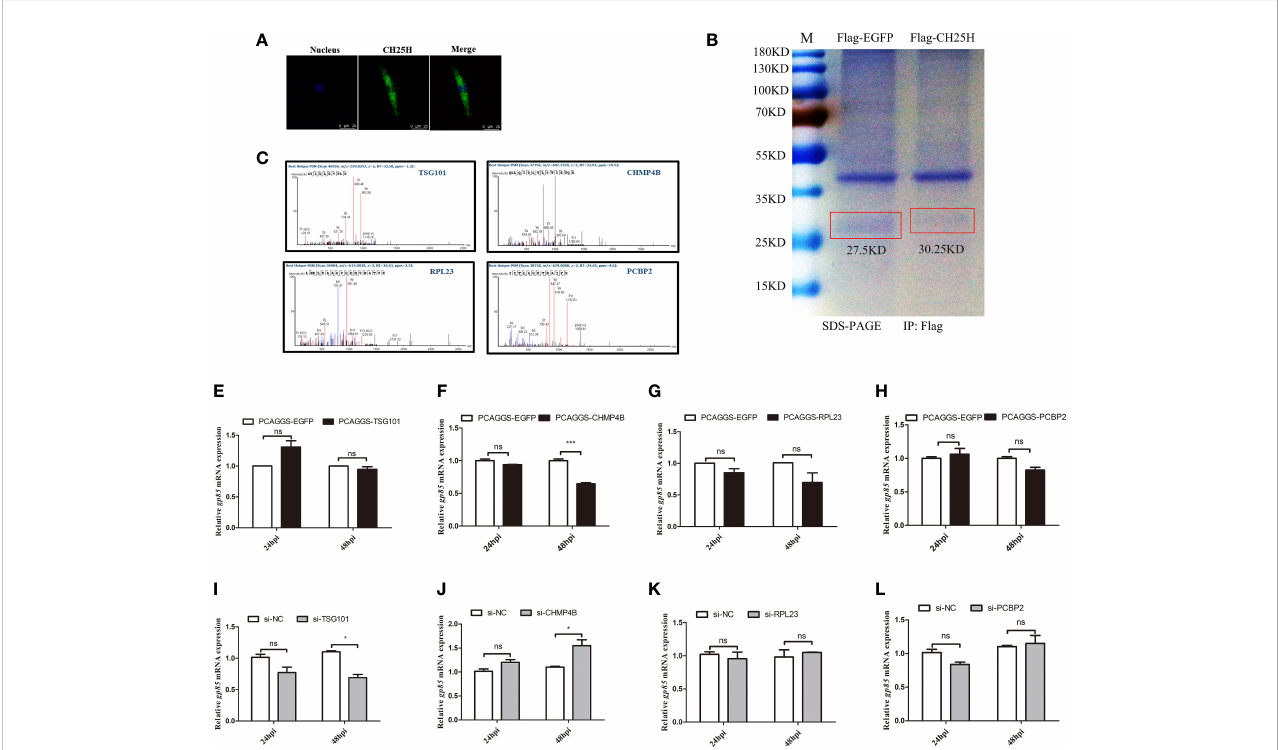
FIGURE 5 The identi fi cation of candidate CH25H-interacting proteins. (A) fl ag-tagged CH25H was expressed in DF-1 cells for 24 h and subsequently infected with ALV-J (10 5 TCID 50 /0.1mL) for 48 h. CH25H localization was analysed by immuno fl uorescence with anti-FLAG antibody (green). Nuclei were visualized with DAPI (blue). Scale bar, 75 m m. (B) The Coomassie brilliant blue staining of CH25H detected with an anti-FLAG antibody. (C) Mass spectrogram of candidate CH25H-interacting proteins, including TSG101, CHMP4B, RPL23, and PCBP2. (D-G) TSG101 (D) , CHMP4B (E) , RPL23 (F) , and PCBP2 (G) were overexpressed in DF-1cells for 24 h and subsequently infected with ALV-J (10 5 TCID 50 /0.1mL), respectively. gp85 mRNA levels were detected by qRT- PCR at 24 hpi and 48 hpi. (H-K) Small interfering RNA (siRNA) was used to silence TSG101 (H) , CHMP4B (I) , RPL23 (J) , and PCBP2 (K) DF-1 cells for 24 h and subsequently infected with ALV-J (10 5 TCID 50 /0.1mL), respectively. gp85 mRNA levels were detected by qRT-PCR at 24 hpi and 48 hpi. *P < 0.05, ***P < 0.001, ns: Non-signi fi